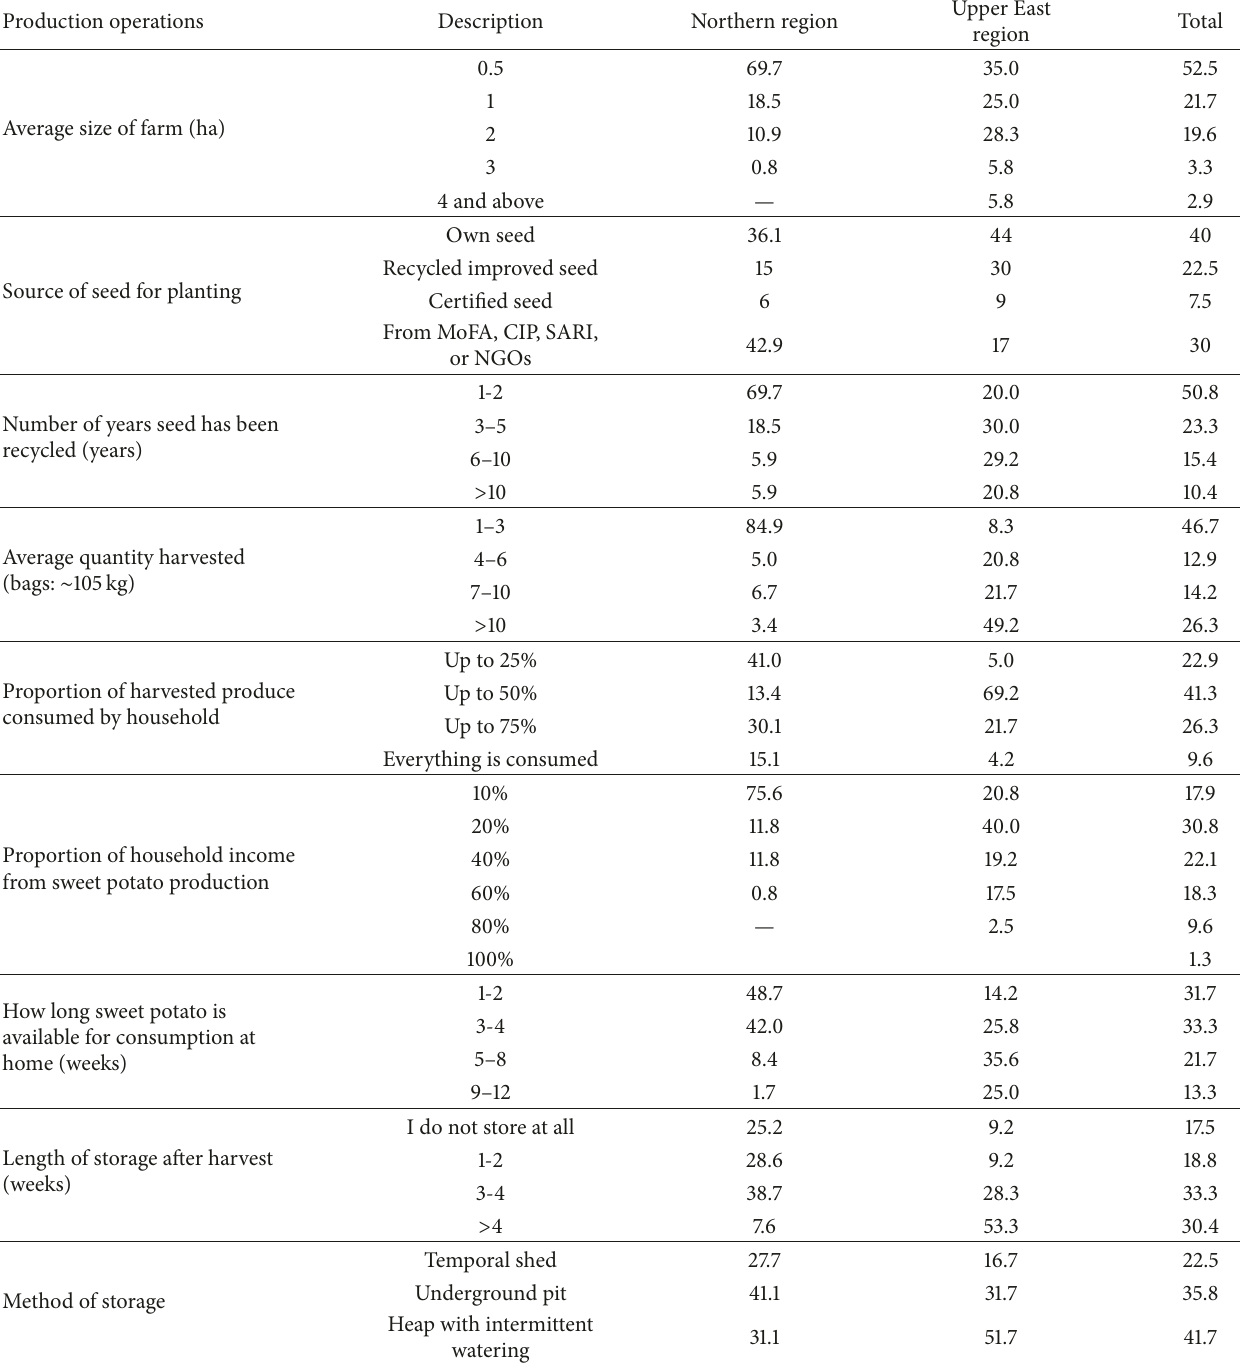
Table 3: Characteristics of sweet potato production operations (%